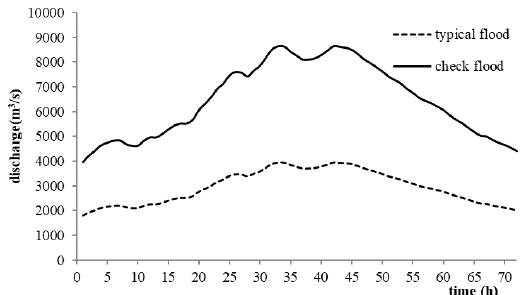
Figure 14. SJK dam check flood hydrographs and measured flood hydrograph in 1981.